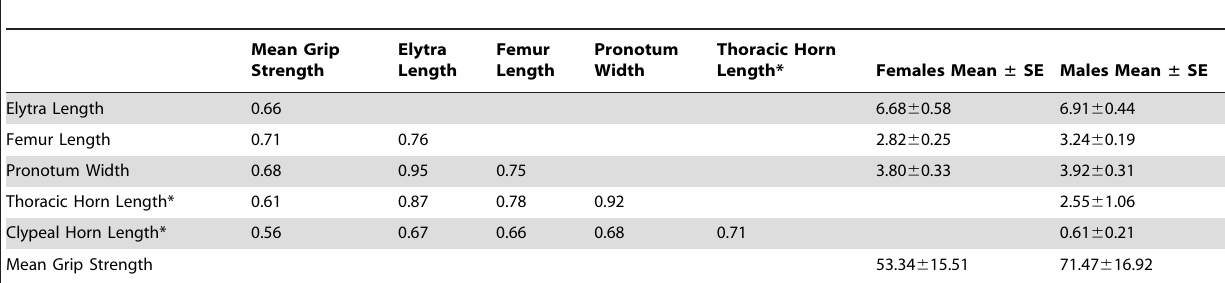
Table 1. Correlations among morphological traits (mm) and grip strength (g) in the tested sample of B. cornutus